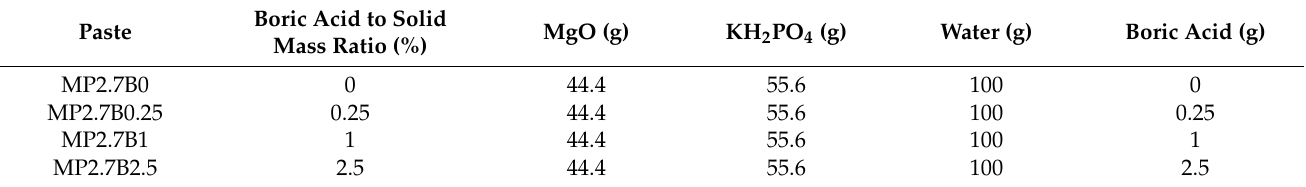
Table 5. Mix proportion of MKPC pastes with boric